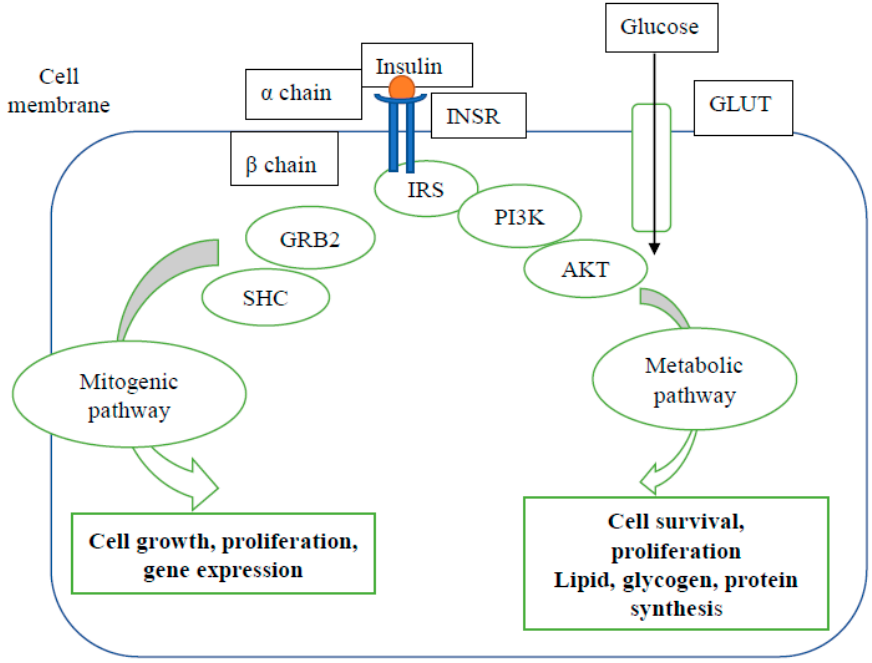
Figure 1. Insulin signalling pathway. Upon binding with insulin, the insulin receptor (INSR) au- tophosphorylates and recruits various substrates. The two major arms of insulin signalling are mitogenic (initiated by Growth factor receptor-bound protein 2 (GRB2) and Src homology and colla- gen (SHC)) and metabolic (initiated by insulin receptor substrate (IRS) proteins). In the metabolic pathway, phosphorylated IRS activates phosphoinositide-3-kinase (PI3K) with subsequent phospho- rylation of protein kinase B (AKT). The glucose transporters (GLUTs) are the main insulin-responsive glucose carriers that transport glucose between the cell membrane and intracellular organelles. The mitogenic pathway regulates cell growth, proliferation and gene expression, while the metabolic pathway regulates cell survival, proliferation, lipid, glycogen and protein synthesis (figure adapted from Peterson et al. [39] and modified by the authors).